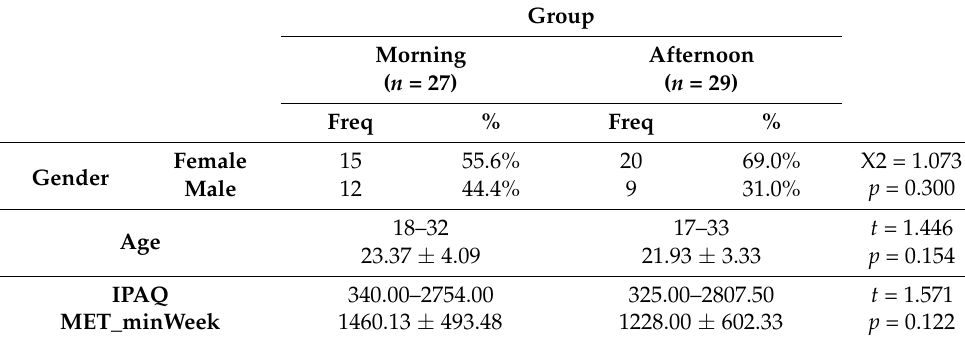
Table 1. Participant characteristics and